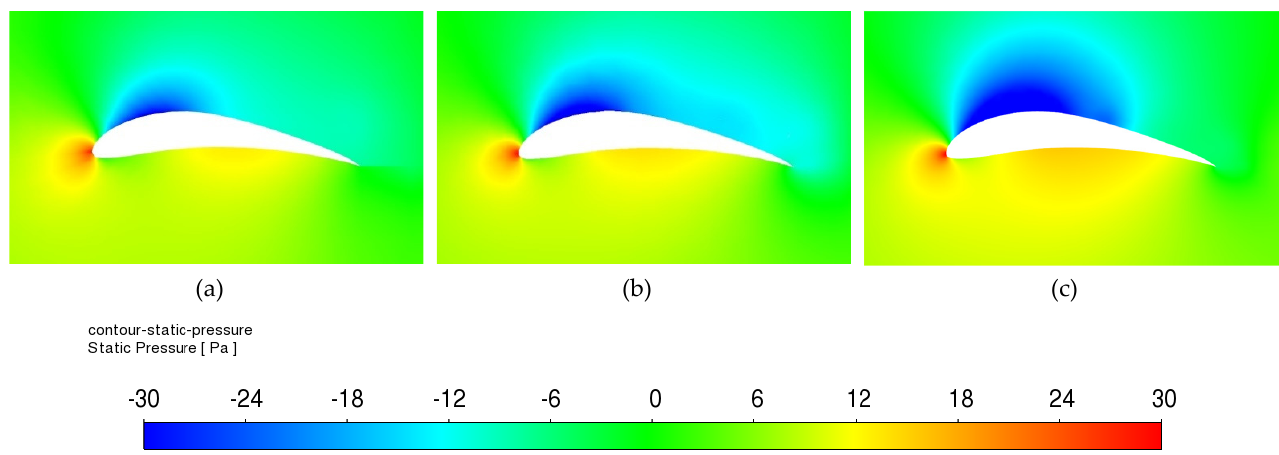
Figure 13. Static pressure distribution around airfoil at 75% of wingspan, angle of attack 20 degrees at ( a ) structured mesh ( b ) unstructured mesh ( c ) mosaic poly-hexcore mesh.